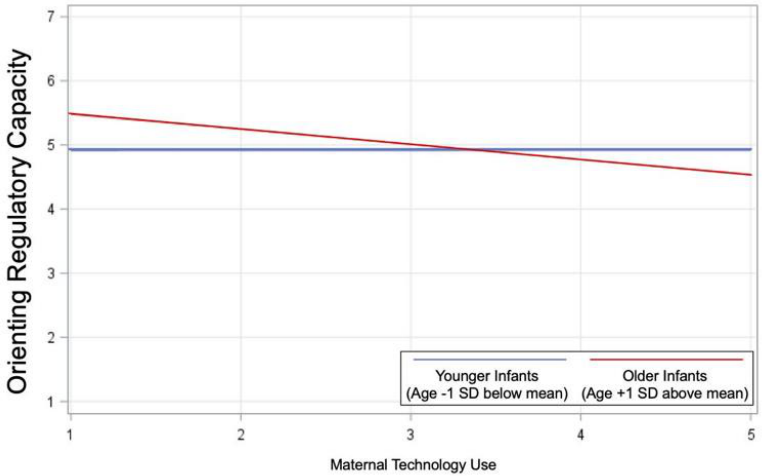
Figure 2. Infant age moderated associations between maternal tech use and orienting/regulatory capacity ( p = 0.04). The negative association between increased frequency of maternal tech use and infant orienting/regulatory capacity was not significant for younger infants ( age −1 SD below aver- age ; p = 0.94) but was significant for older infants (age +1 SD above average ; p = 0.01).